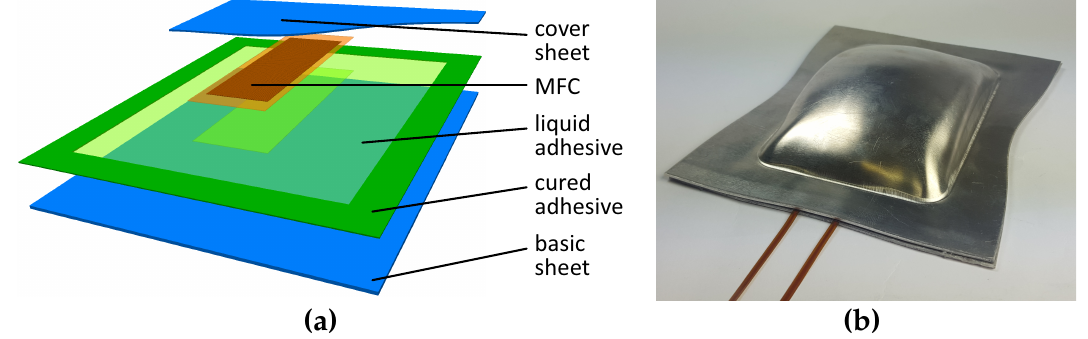
Figure 1. ( a ) exploded view of a piezoceramic-metal compound before forming and ( b ) complex-shaped structural part with integrated actuator/sensor functionality after